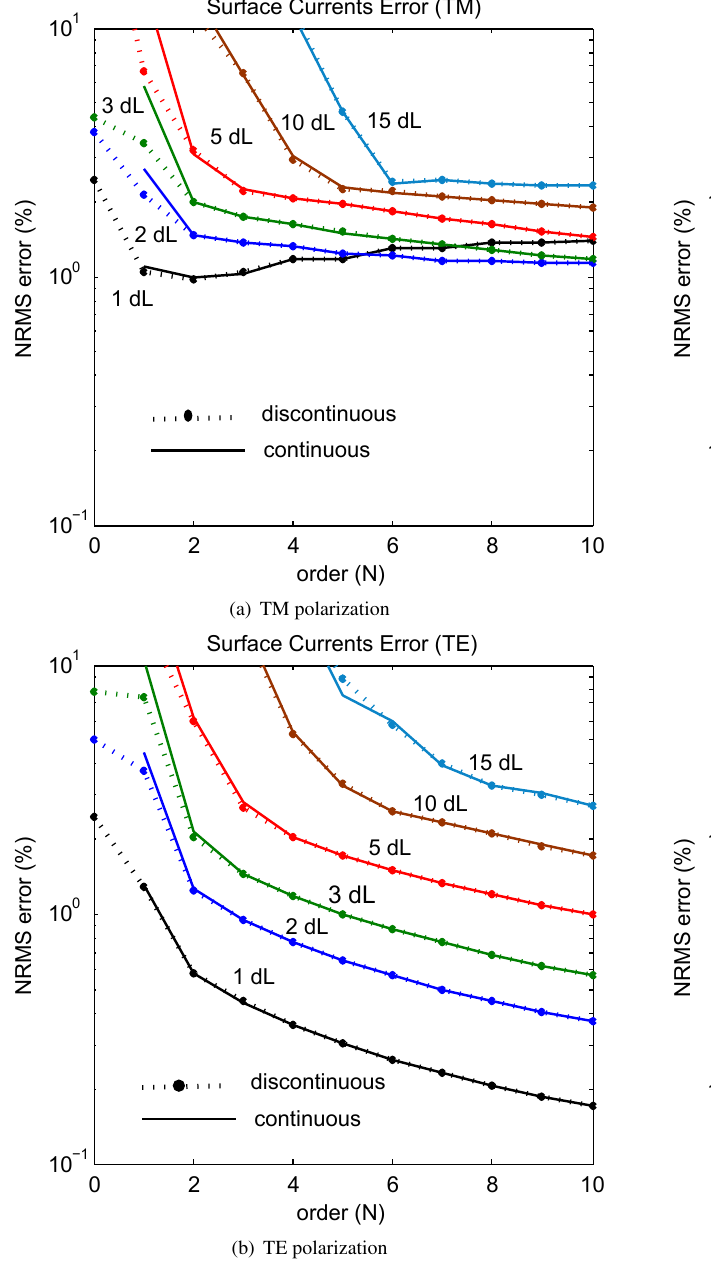
Figure 12: Log plot of surface currents error versus the or- der and λ for L = 1 dL = λ/ 10